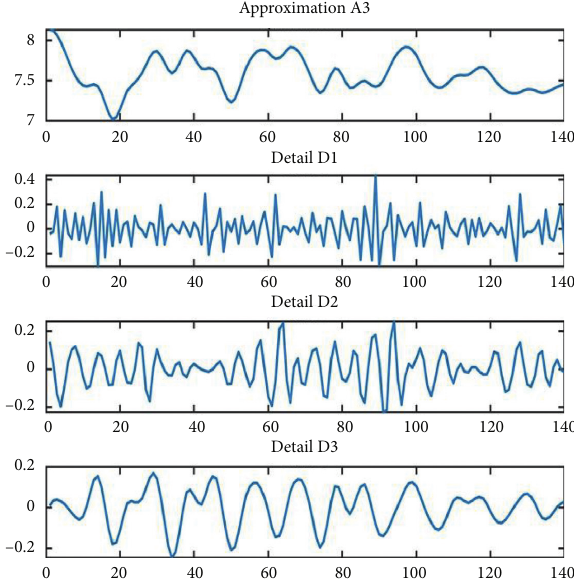
Figure 11: Wavelet decomposition for pH values at